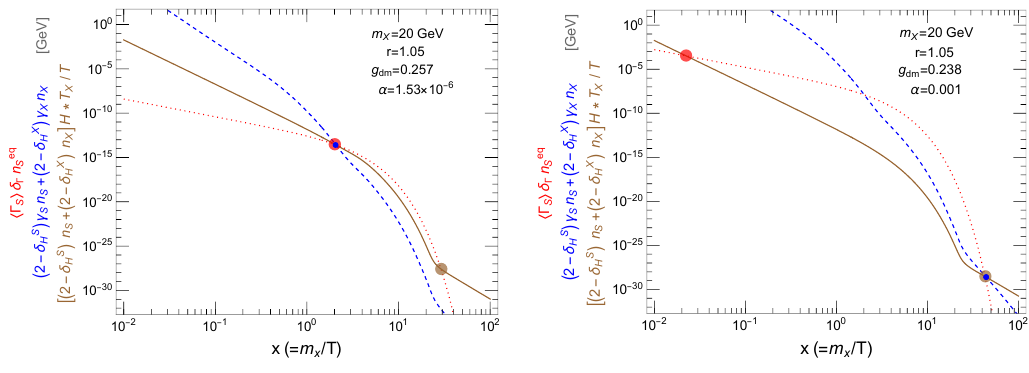
Figure 5 . Comparison of the kinetic energy injection rates from the SM bath to hidden sector via the inverse S decay (red dotted line) and elastic scattering (blue dashed line), and the cooling rate due to the cosmic expansion (brown solid line). Here, these magnitudes of rates have been scaled by a factor of 1 /T . Below the temperature denoted by the blue dot, the elastic scattering rate falls below the expansion rate in magnitude. In contrast, the inverse S decay rate is larger than the expansion rate when the temperature drops below that, denoted by the red dot. At a later time, the inverse S decay rate falls below the cosmic rate at the temperature denoted by the brown